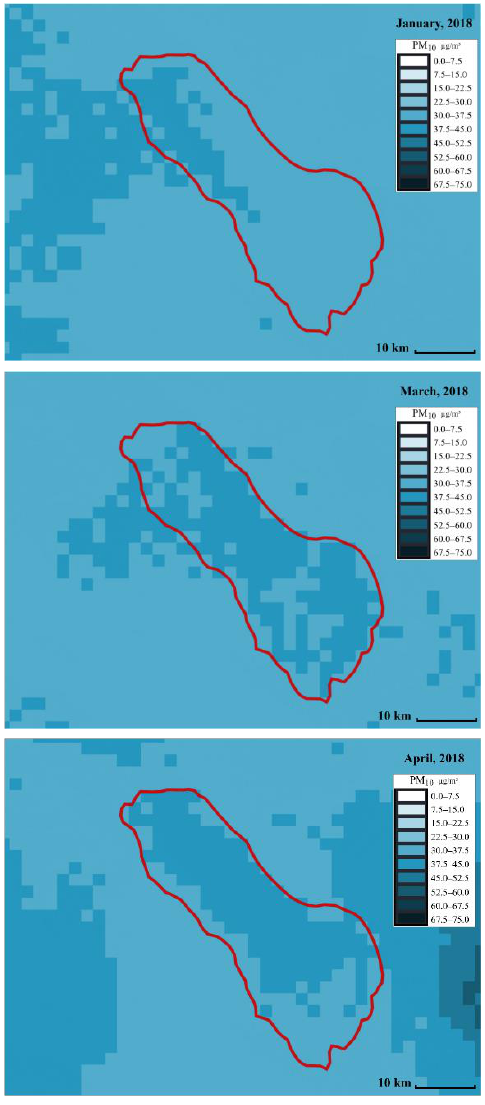
Figure 6. PM 2.5 map using a stacked ensemble model in the Salton Sea area from January to December (created by author).